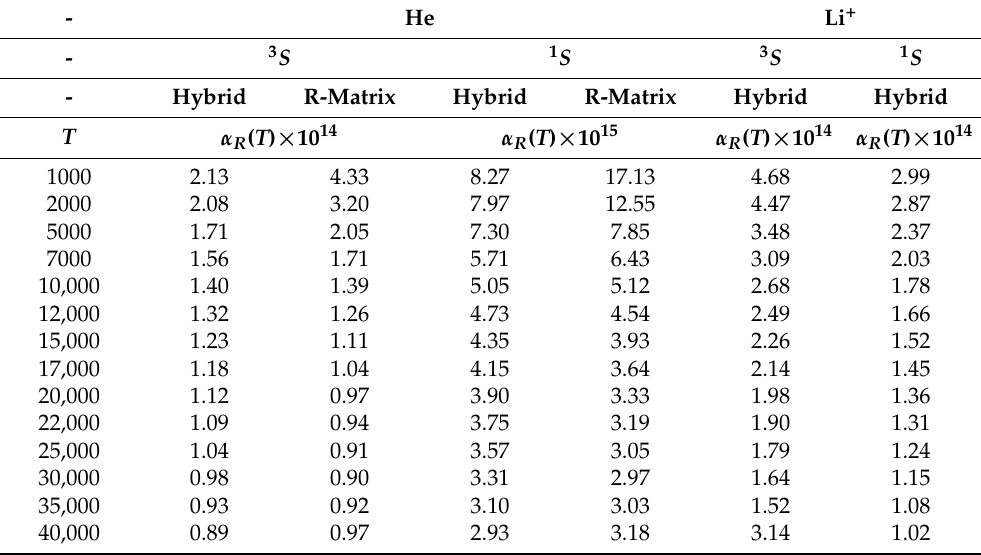
Table 7. Recombination rate coefficients (cm 3 /s) of the metastable states of He and Li + , and compari- son with the R-matrix results